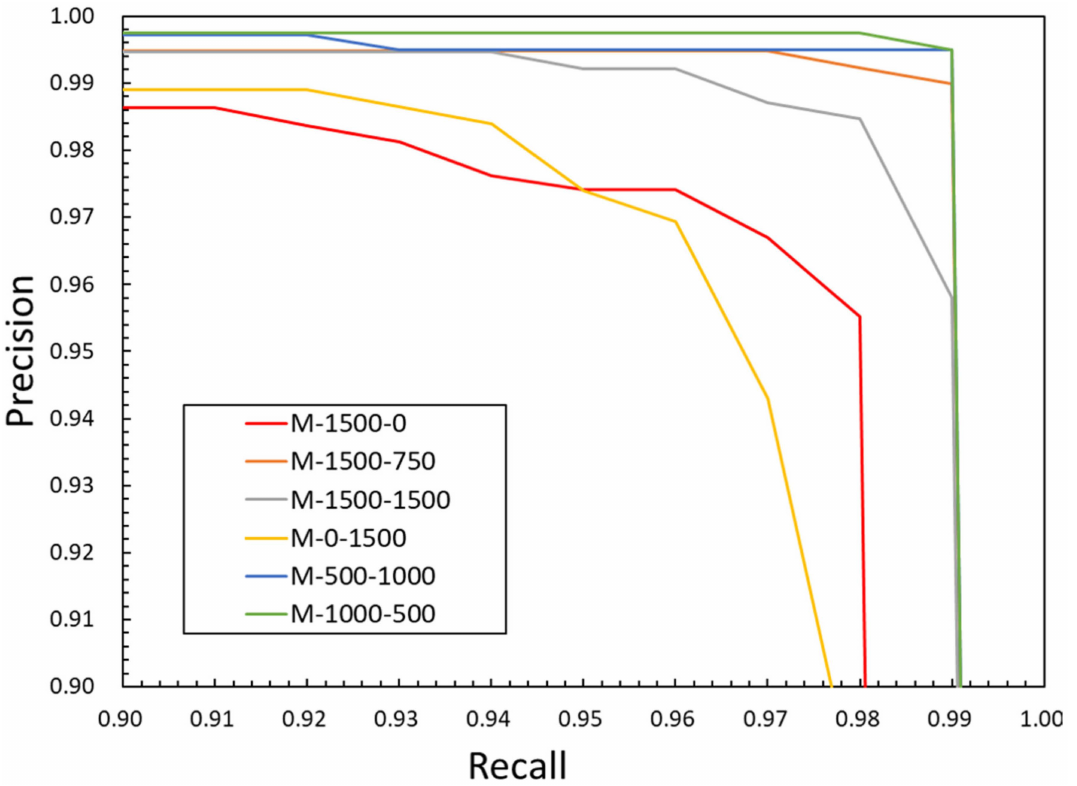
Figure 16. Precision–recall